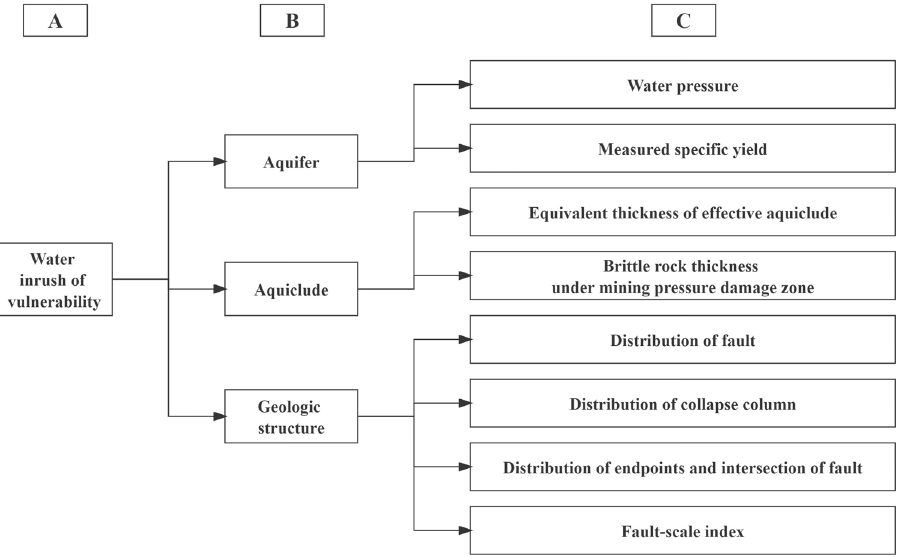
Figure 7. The AHP model for this